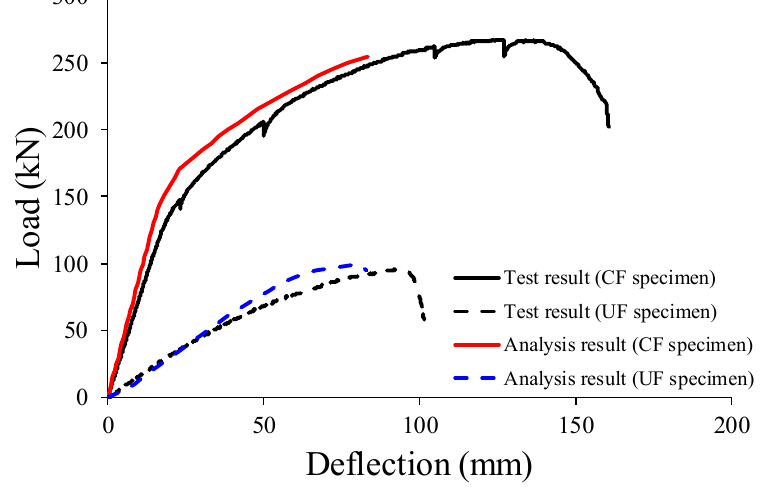
Figure 10. Comparison of the test and analysis results on the flexural specimens.